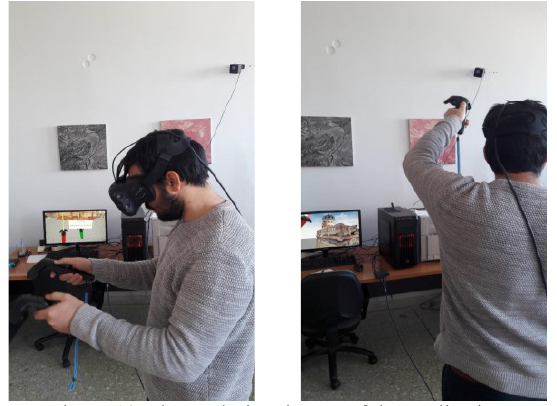
Figure 10. Photos during the use of the